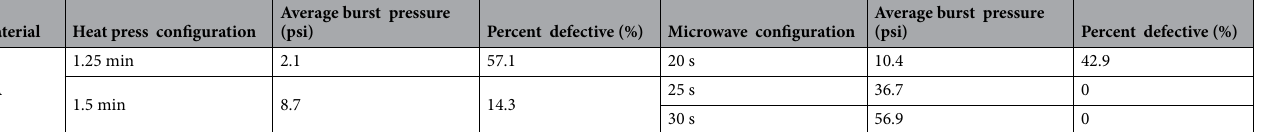
Table 1. Average burst pressures along with percent defective device for different configurations of CA bonding via the heat press and microwave techniques. Seven iterations have been performed for each of the